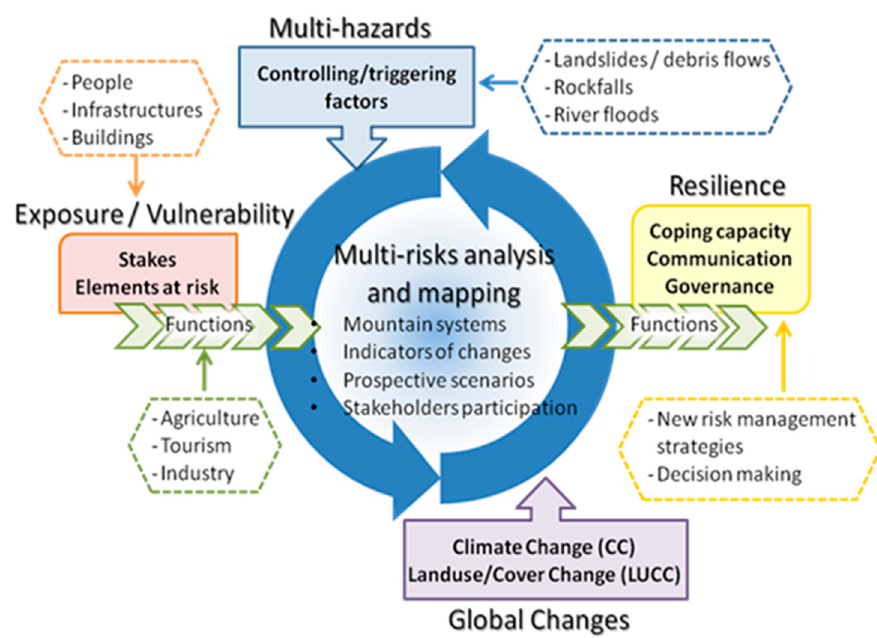
Figure 1. Conceptual approach of the SAMCO (Society Adaptation for coping with Mountain risks in a global change COntext) project. Three aspects are considered (multi-hazards, exposure/vulnerability and resilience) as well as forcing factors like climate change (CC) and land use/cover changes (LUCC), all of them being assessed by the mean of maps socio-economic functions evolution.